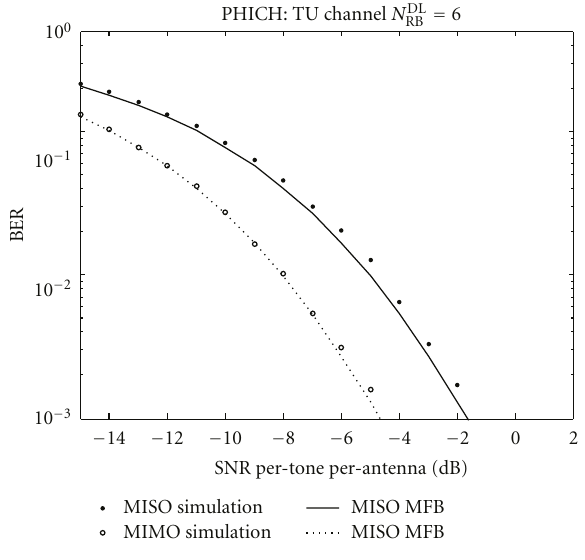
Figure 7: PHICH performance in TU channel.